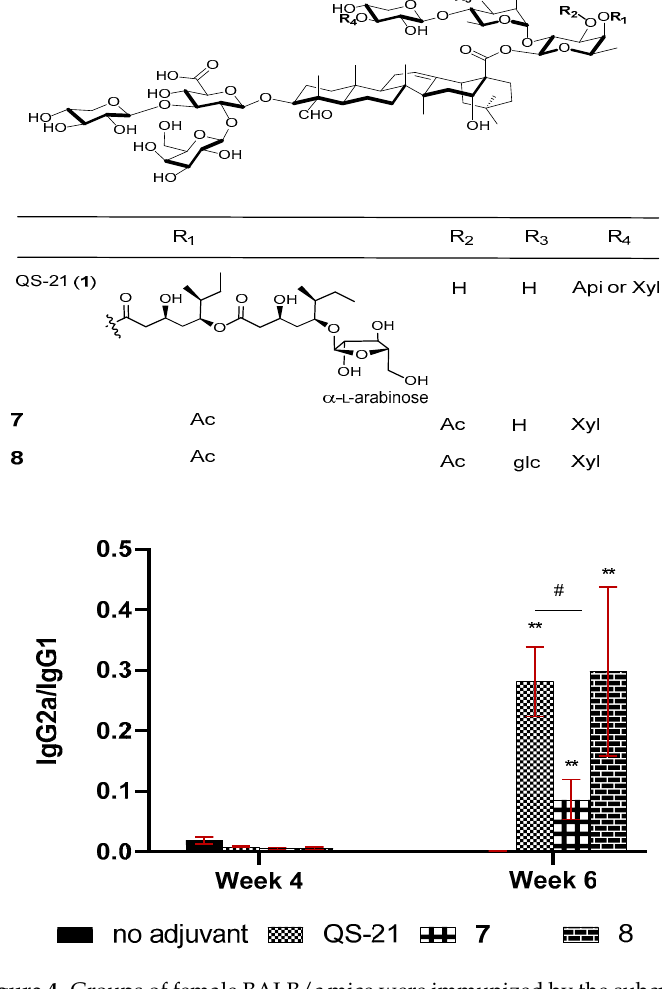
Figure 4. Groups of female BALB/c mice were immunized by the subcutaneous route (s.c.) with OVA (20 µ g) alone or with QS-21 (20 µ g), or a synthetic saponin (50 µ g). IgG2a/IgG1 ratios are expressed as mean ± SEM. Statistical significance was evaluated by t tests (with unpaired, nonparametric, and Mann-Whitney test). ** p < 0.01 compared with the group of OVA alone, and # p < 0.05 compared between the indicated groups.